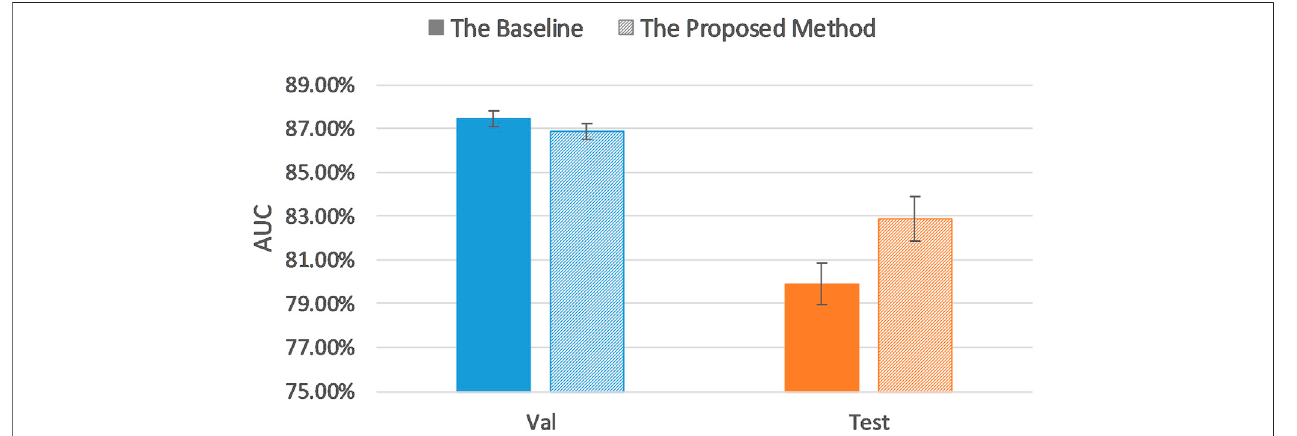
FIGURE 5 | Comparison of AUC results of the proposed method and baseline.